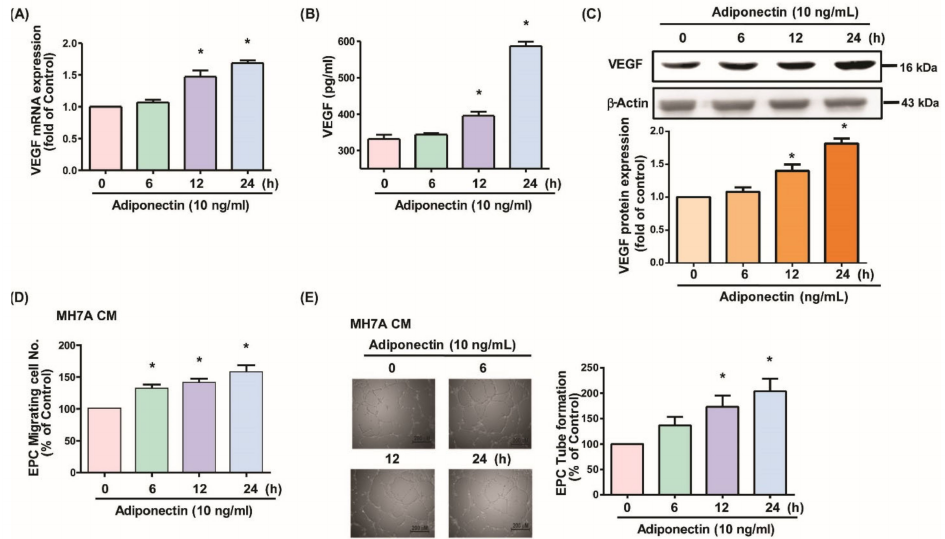
Figure 2. Adiponectin time-dependently enhances VEGF production in MH7A cells and EPC angiogenesis. ( A – C ) MH7A cells were treated with adiponectin (10 ng/mL) for 6, 12, and 24 h. VEGF expression was examined by qPCR, ELISA, and Western blotting ( n = 4 per group). ( D , E ) MH7A cells were treated with adiponectin (10 ng/mL) for 6, 12, and 24 h. Medium was collected as CM; 200 µ L of 20% FBS MV2 medium and 150 µ L of MH7A CM was applied to the EPCs. Capillary-like structure formation and in vitro cell migration in EPCs were examined by the Transwell and tube formation assays ( n = 5 per group). * p < 0.05 versus the control